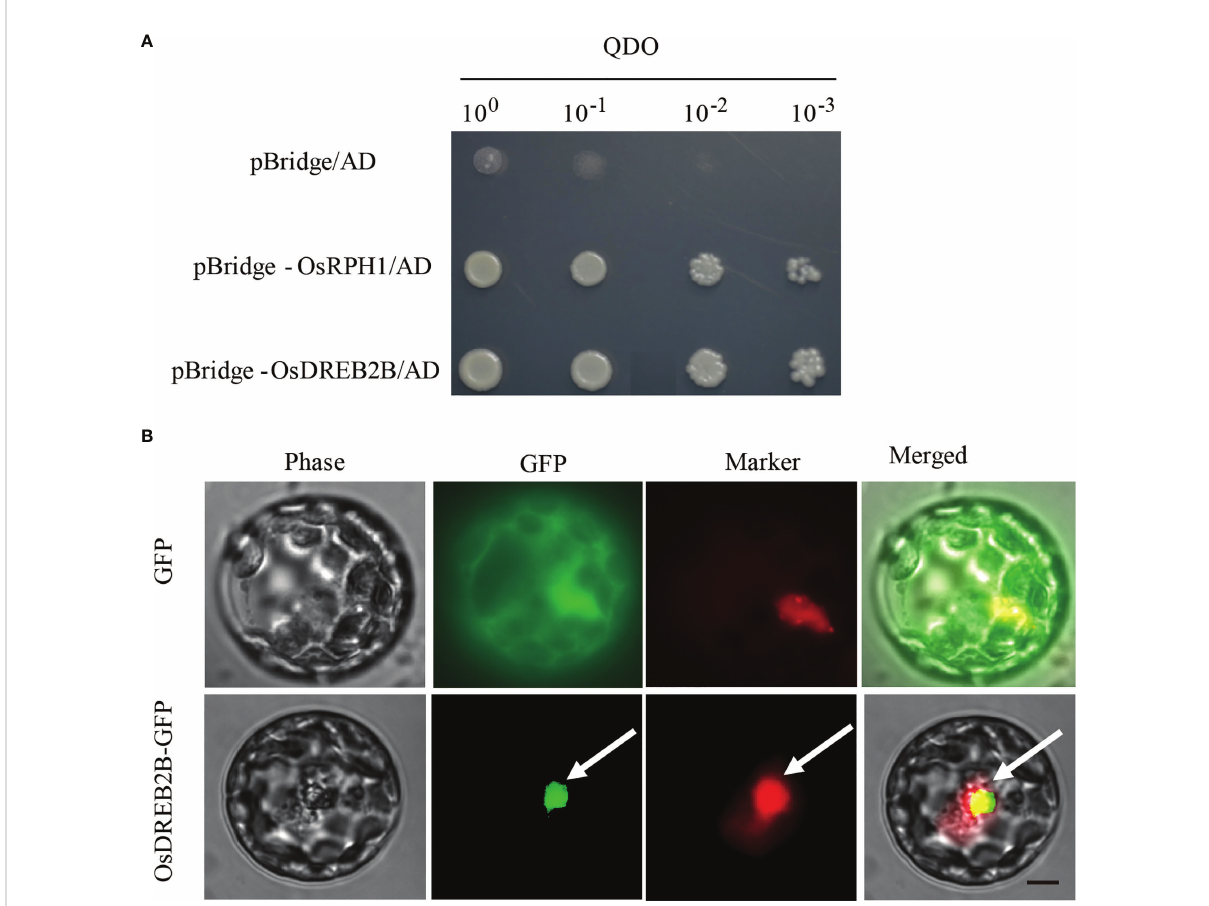
FIGURE 7 Trans-activation activity and subcellular localization of OsDREB2B. (A) Trans-activation analysis of the OsDREB2B protein in yeast. BD, GAL4- DNA binding domain. The OsRPH1 protein was used as a positive control. (B) Subcellular localization of OsDREB2B-GFP fusion proteins in rice protoplast cells. D53-RFP was used as a nuclear marker. Bar = 10